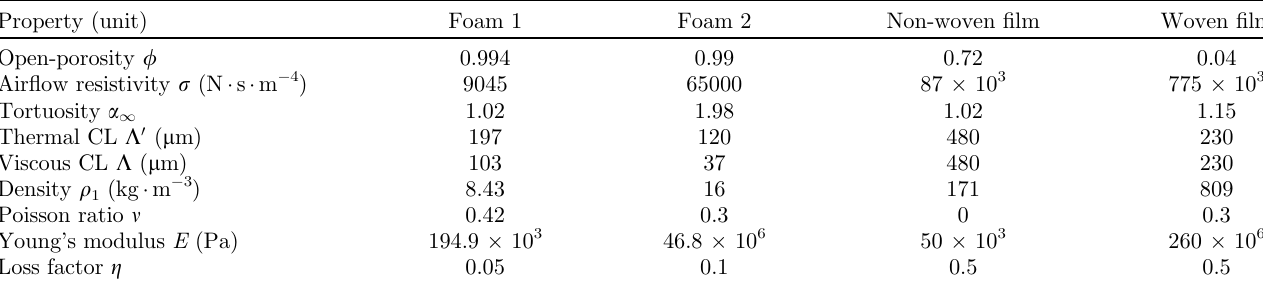
CL stands for characteristic